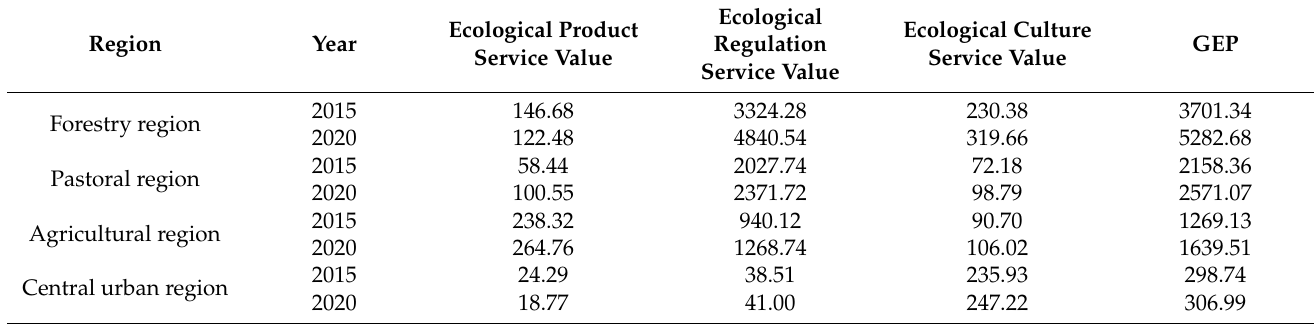
Table 2. Accounting results of GEP on each region in 2015 and 2020 (100 million · a − 1 ).